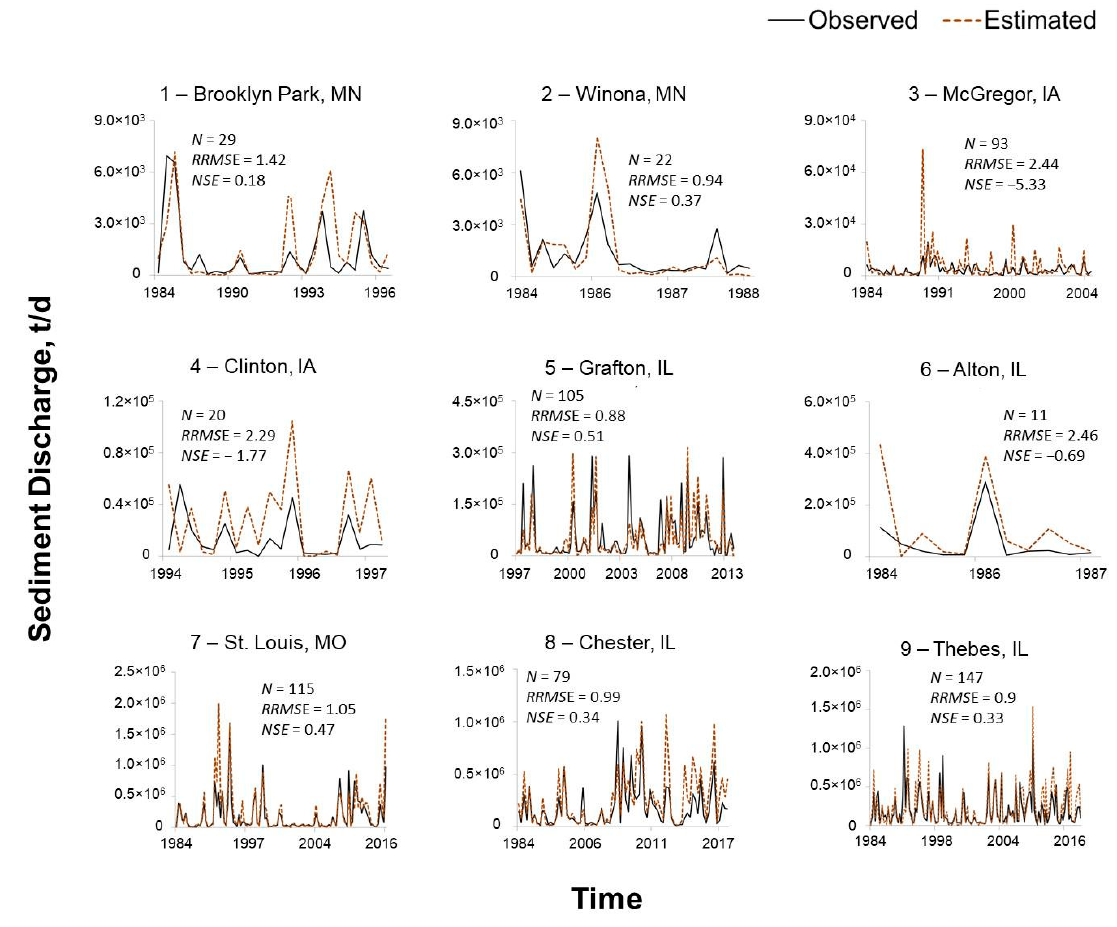
Figure 11. Estimated and observed sediment discharges for the individual study sites.